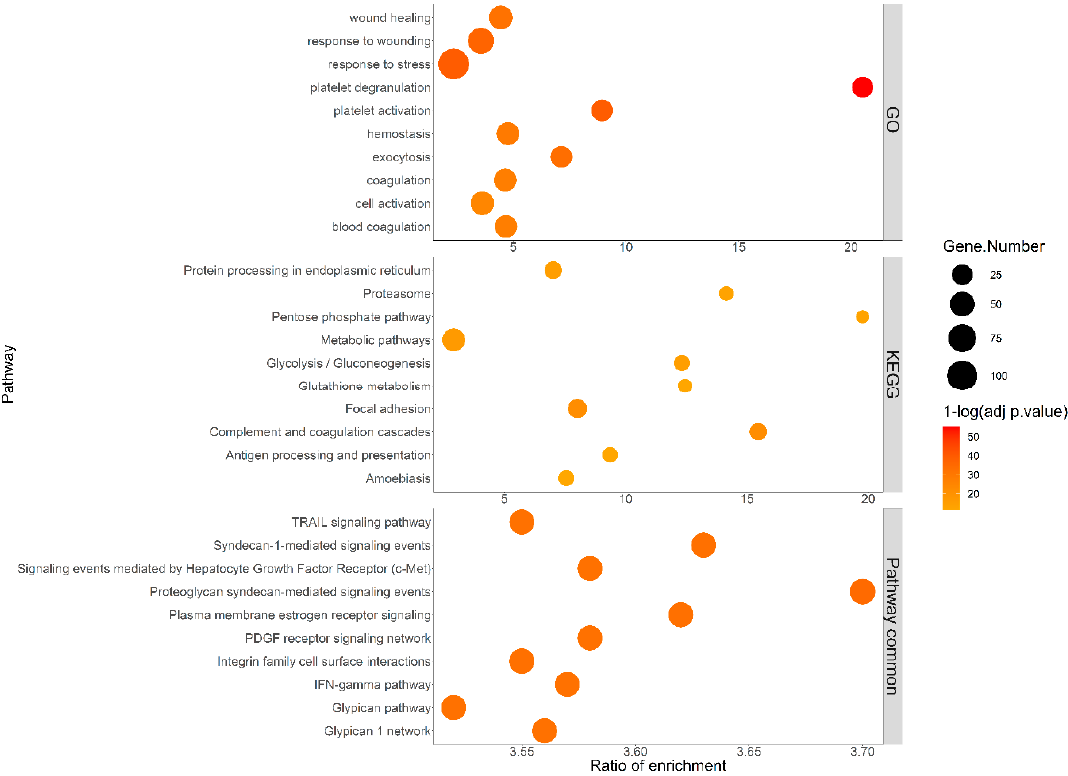
Figure 1. Pathway enrichment analysis of the differentially expressed proteins in plasma from lung cancer patients and healthy donors. The enrichment analysis was done using Pathway Commons, Kyoto encyclopedia of genes and genomes (KEGG) and gene ontology (GO) databases. The top 10 significantly enriched pathways are shown. The analysis was done based on the concentrations of the 229 differentially expressed proteins in plasma from lung cancer patients ( n = 128) and healthy volunteers ( n = 93).